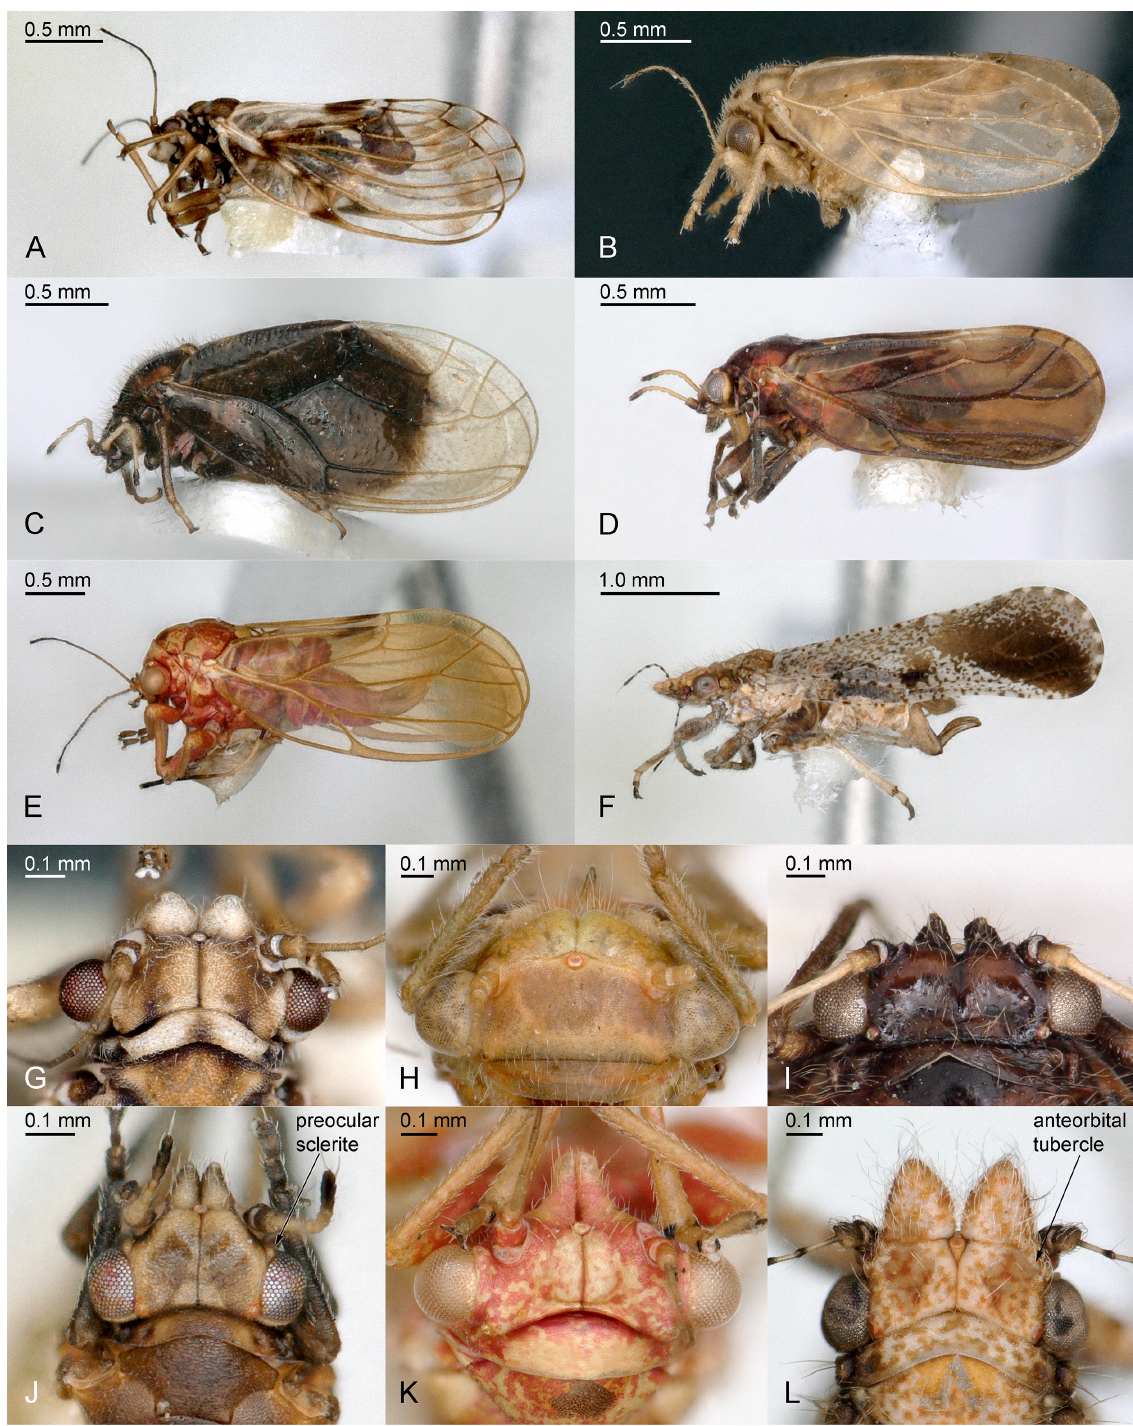
Fig. 7. Katacephalinae subfam. nov. A, G . Katacephala longiramis (Burckhardt, 1987). B . Katacephala tenuipennis Tuthill, 1944. C, I . Lautereropsis sp. D, J . Notophorina brevicornis Burckhardt, 1987. E, K . Notophorina sp. F, L . Tuthillia sp. H . Katacephala sp. A–F . Habitus, in profile view. G–L . Head, dorsal